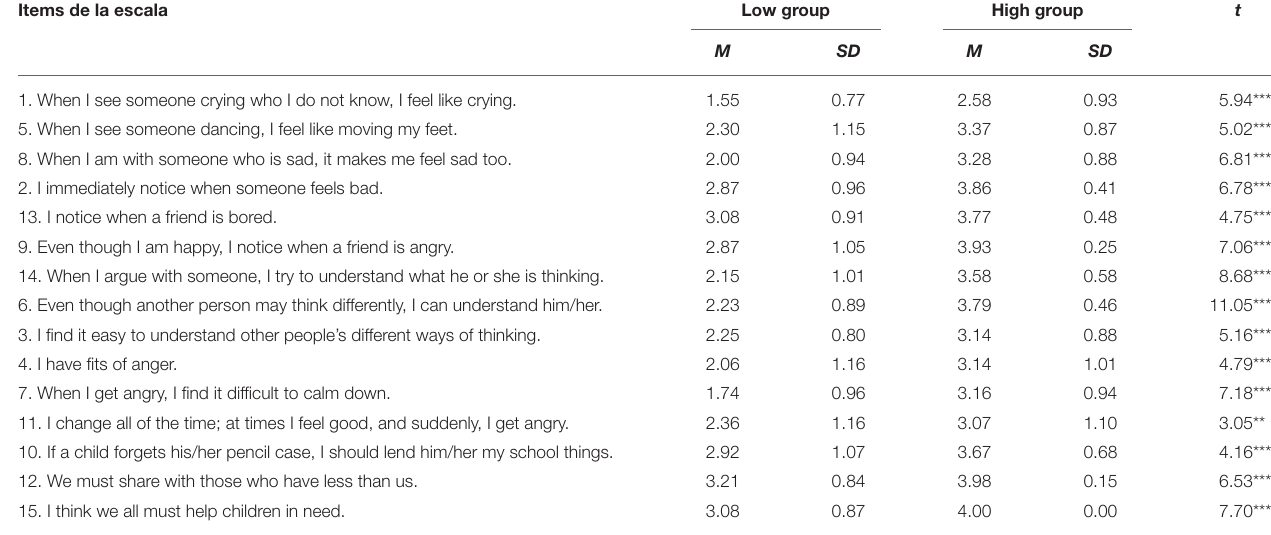
TABLE 1 | Discriminative power of the items in the final version of the scale. Items de la